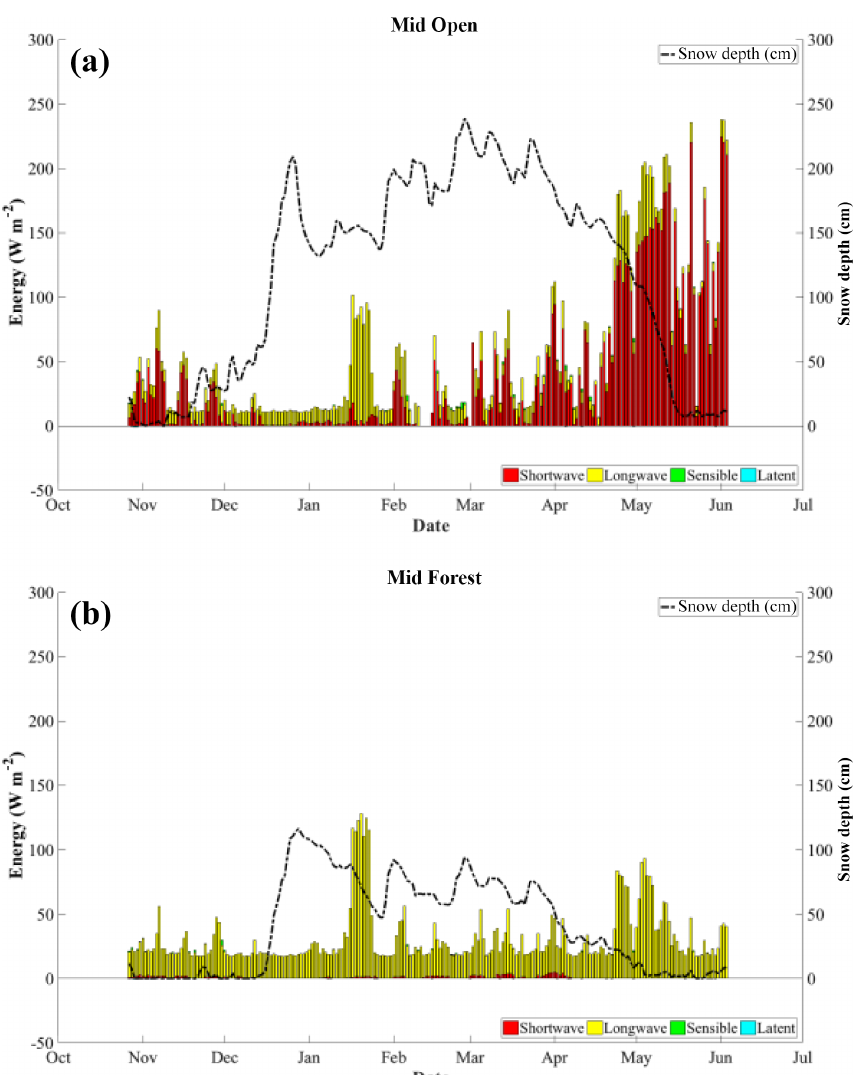
Figure 5. Calculated daily mean energy balance component magnitudes (bars) and the daily measured snow depth (dashed line) for Mid Open (a) and Mid Forest (b) during WY